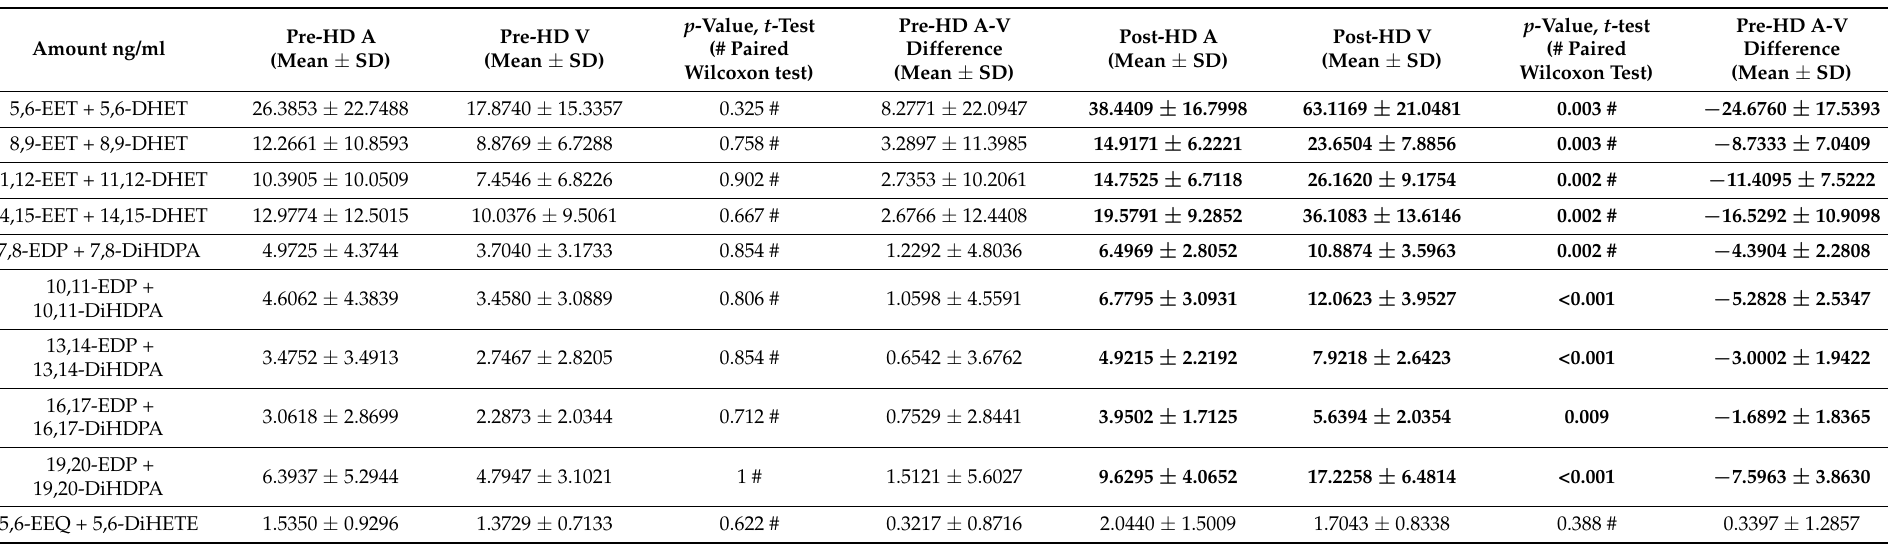
Table 3. Effects of hemodialysis on total plasma oxylipins and their ratios in the CKD patients before (pre-HD) and at cessation (post-HD) of hemodialysis ( n = 12